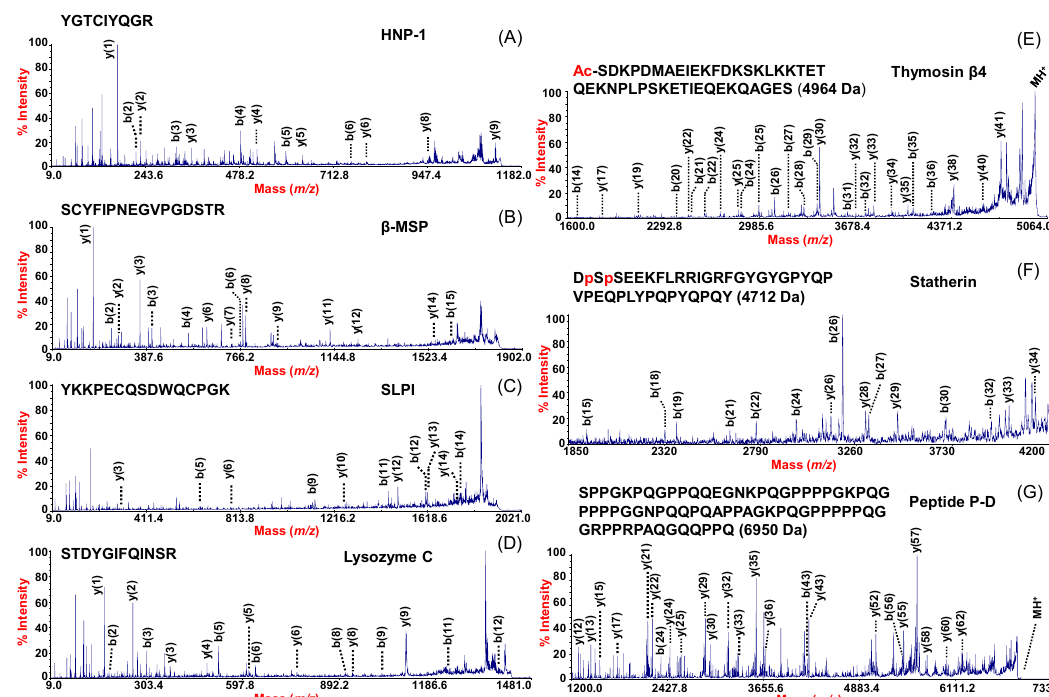
Figure 2. MALDI-TOF/TOF mass spectra of some relevant peptides analyzed by sequence identification directly from NF processed with the MPS or alternatively after gel electrophoresis separation of the captured proteins. The left column shows MS/MS spectra of peptides obtained from triptic digestion of ( A ) HNP1: YGTCIYQGR (residues 80 to 88). ( B ) β-MSP: SCYFIPNEGVPGDSTR (residues 21 to 36). ( C ) SLPI: YKKPECQSDWQCPGK (residues 46 to 60) and ( D ) Lysozyme C: STDYGIFQINSR (residues 69 to 80). The right column shows MS/MS spectra obtained by direct sequencing of ( E ) Thymosin β4 (Red letter Ac: N-terminal acetylated), ( F ) statherin Des 39–43 (Red letter p: phosphorylated on Ser 2 and Ser 3), and ( G ) Peptide P-D.